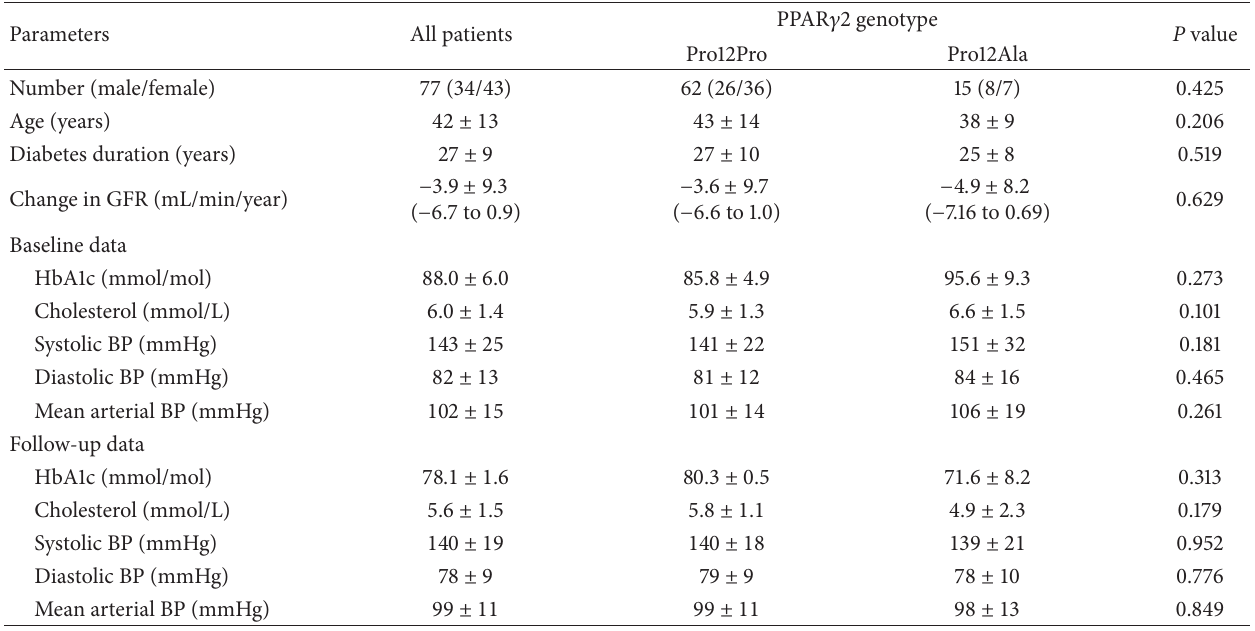
Table 2: Genetic data, baseline and follow-up clinical data (means ± SD), and results of comparing these indicators between the PPAR 𝛾 genotypes in 77 patients with type 1 diabetes and